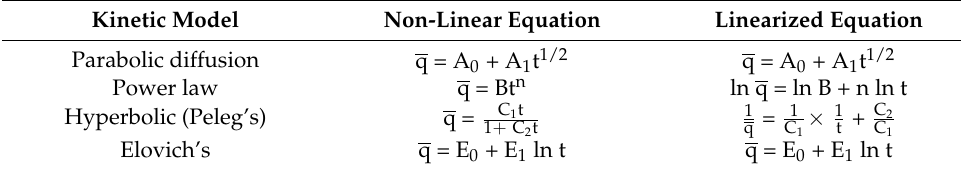
Table 1. Empirical kinetic models. Kinetic Model Non-Linear Equation Linearized Equation Parabolic